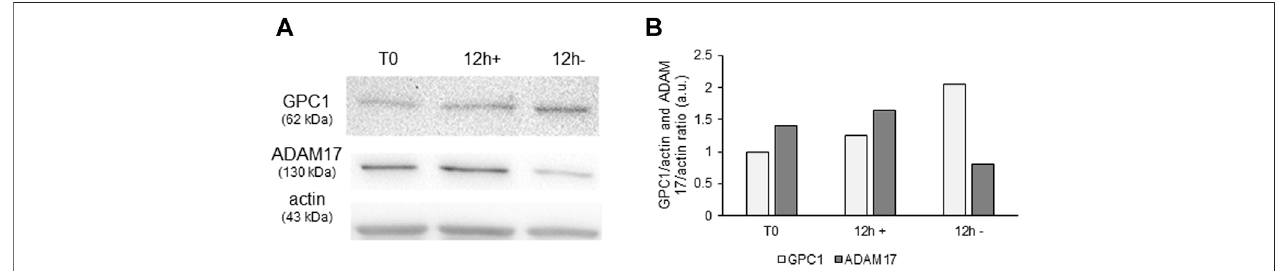
FIGURE 3 | Diagram summarizing the effect of conditioned media from HHFDPC, KORS and HDMEC cultures on the proliferation of each cell type. The KORS CM had the most signi fi cant effect on the HDMEC proliferation ( n (cid:2) 8 replicates and three independent experiments).